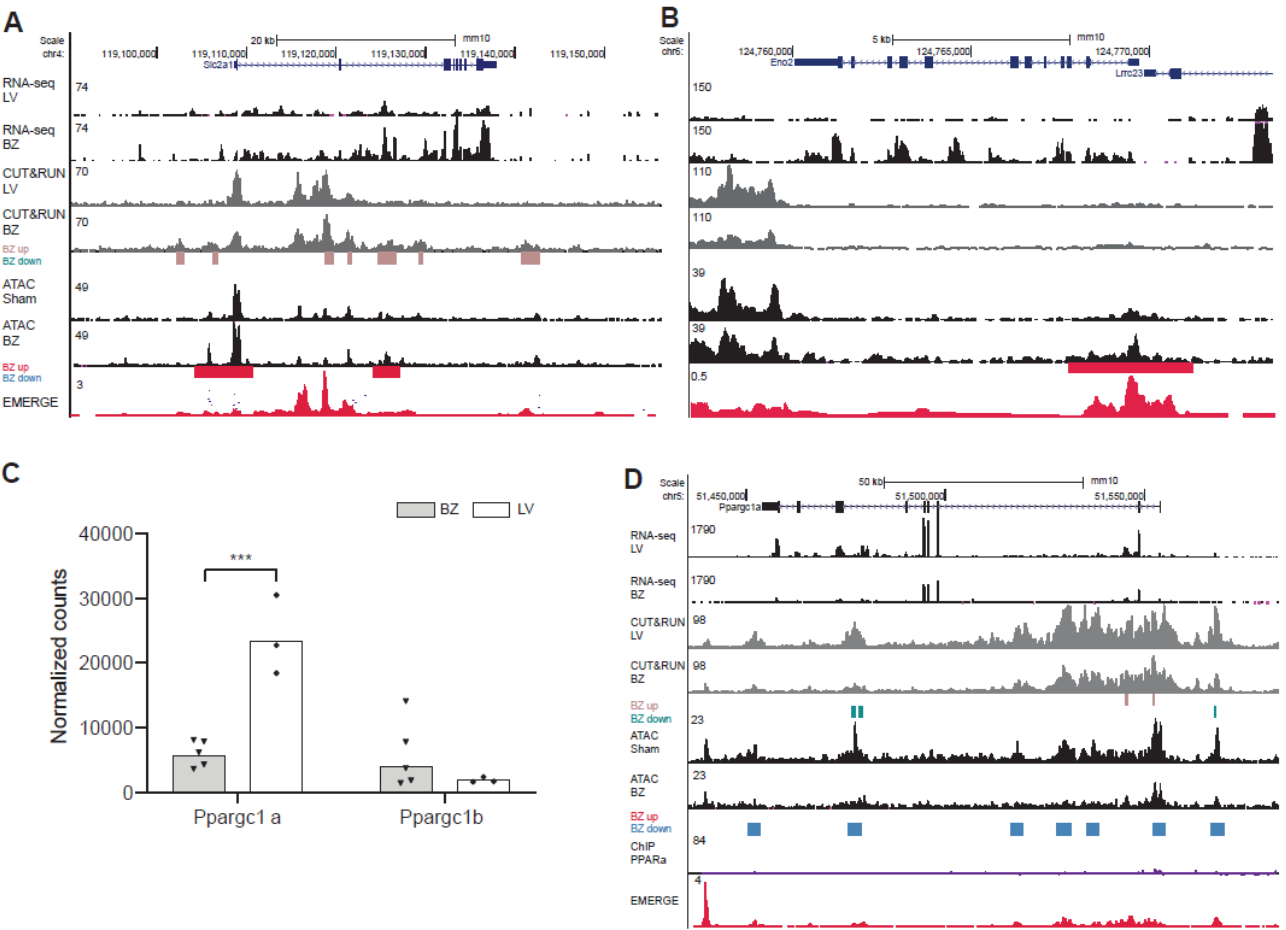
Figure 5. UCSC genome browser views of ( A ) Slc2a1 and ( B ) Eno2 . Average expression of Ppargc1a and Ppargc1b ( C ) shown as normalized counts in border-zone (BZ) samples ( n = 5) and samples from the healthy left ventricle ( n = 3). UCSC genome browser views of ( D ) Ppargc1b . ATAC-seq, assay for transposase-accessible chromatin using sequencing; CUT&RUN-seq, cleavage under target and release using nuclease-sequencing; ChIP, chromatin immunoprecipitation sequencing; BZ, border zone; and LV, left ventricle. *** p < 0.001.